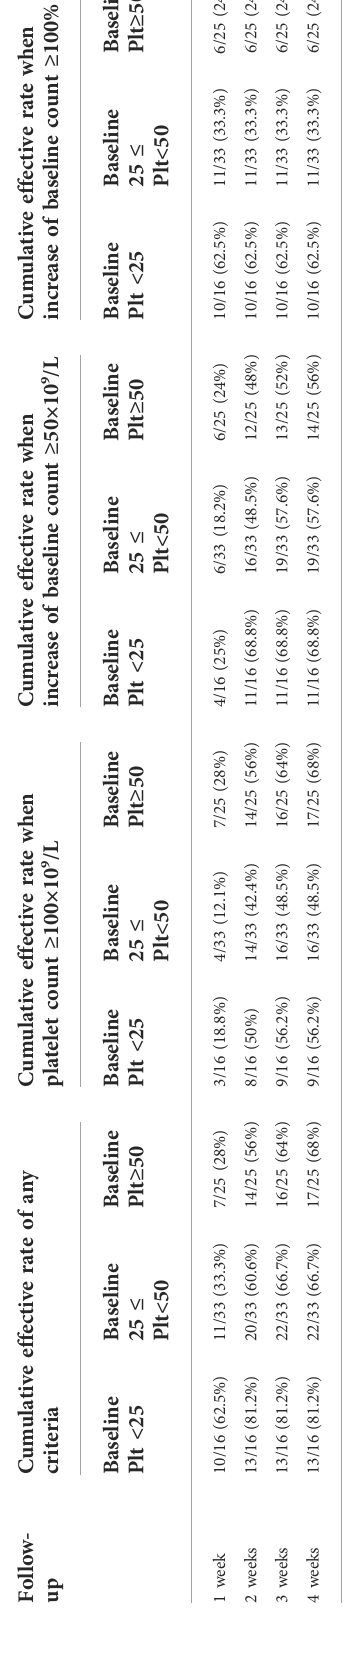
TABLE 4 Platelet transfusion, bleeding, and adverse